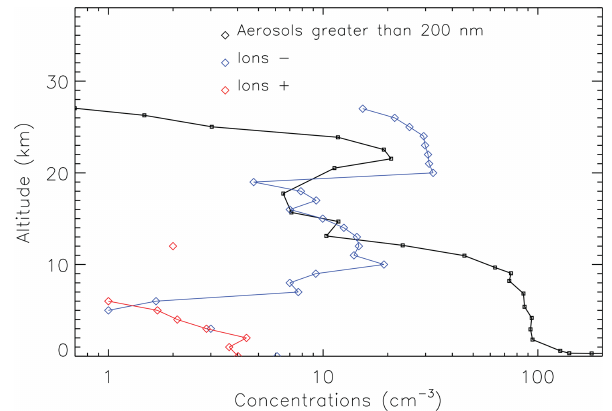
Figure 2. Vertical profiles of integrated aerosol concentration, for aerosols greater than 200nm (black line), and of positive (red line) and negative ions (blue line).